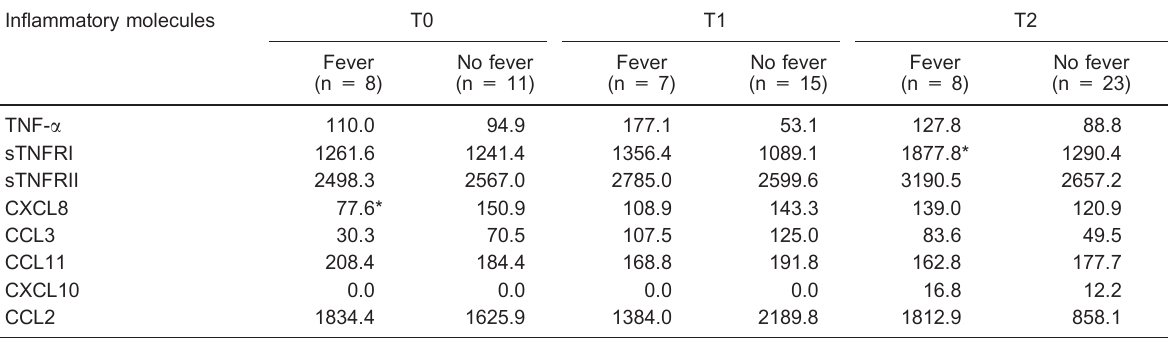
Table 3. Dynamic behavior of the different plasma inflammatory molecule levels in the entire population of neutropenic patients with fever or not. Inflammatory molecules